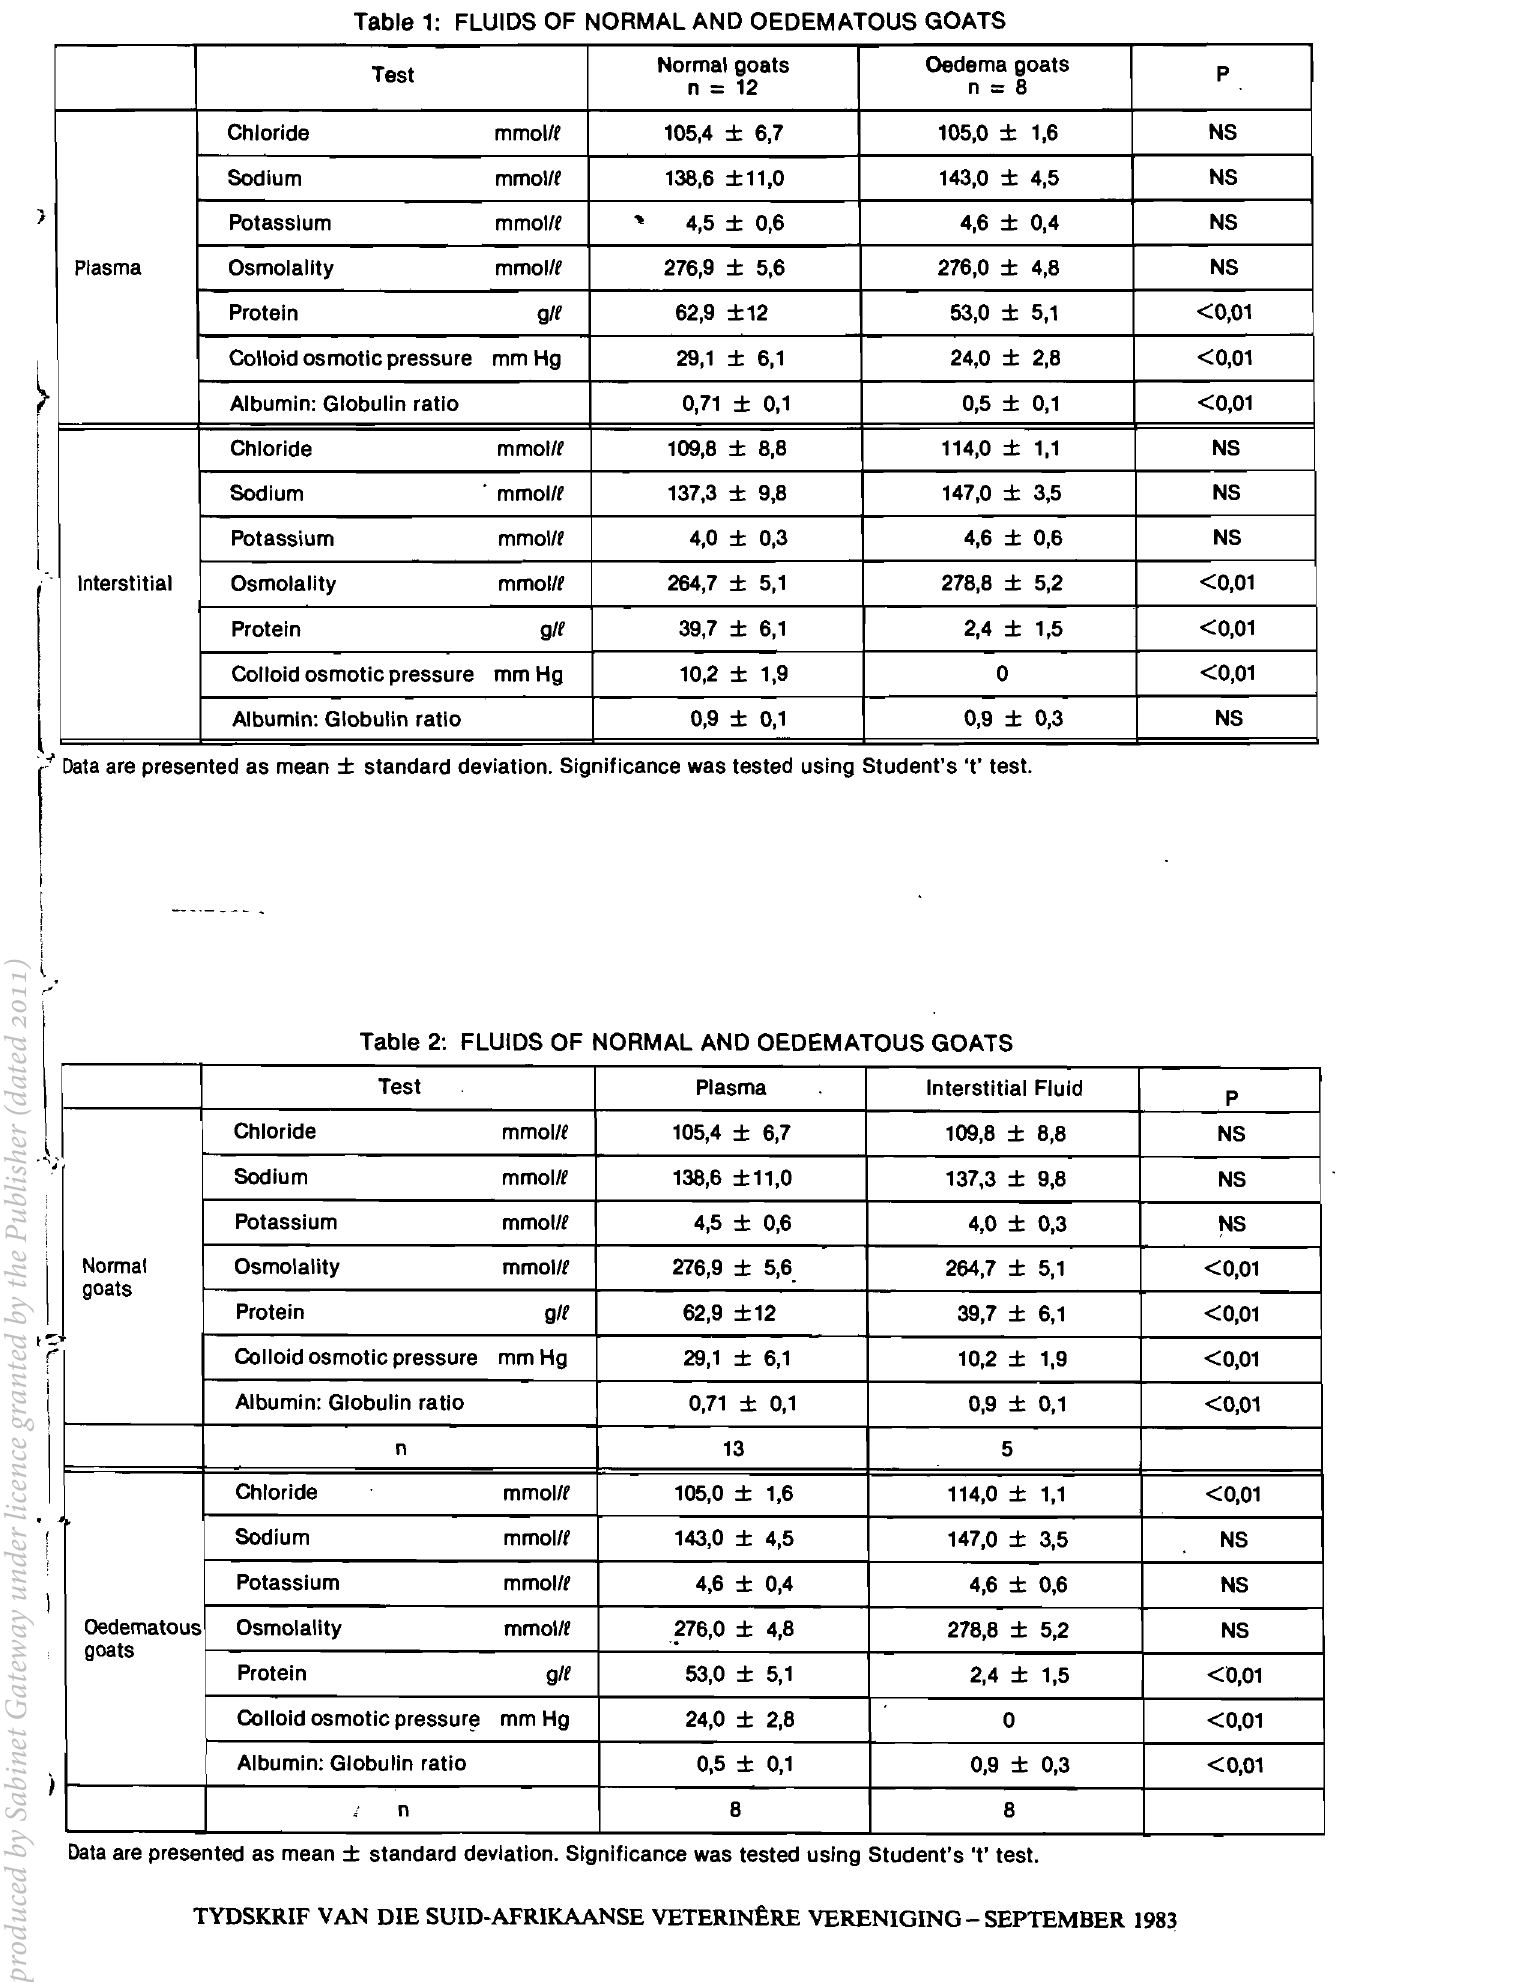
Table 1: FLUIDS OF NORMAL AND OEDEMATOUS GOATS